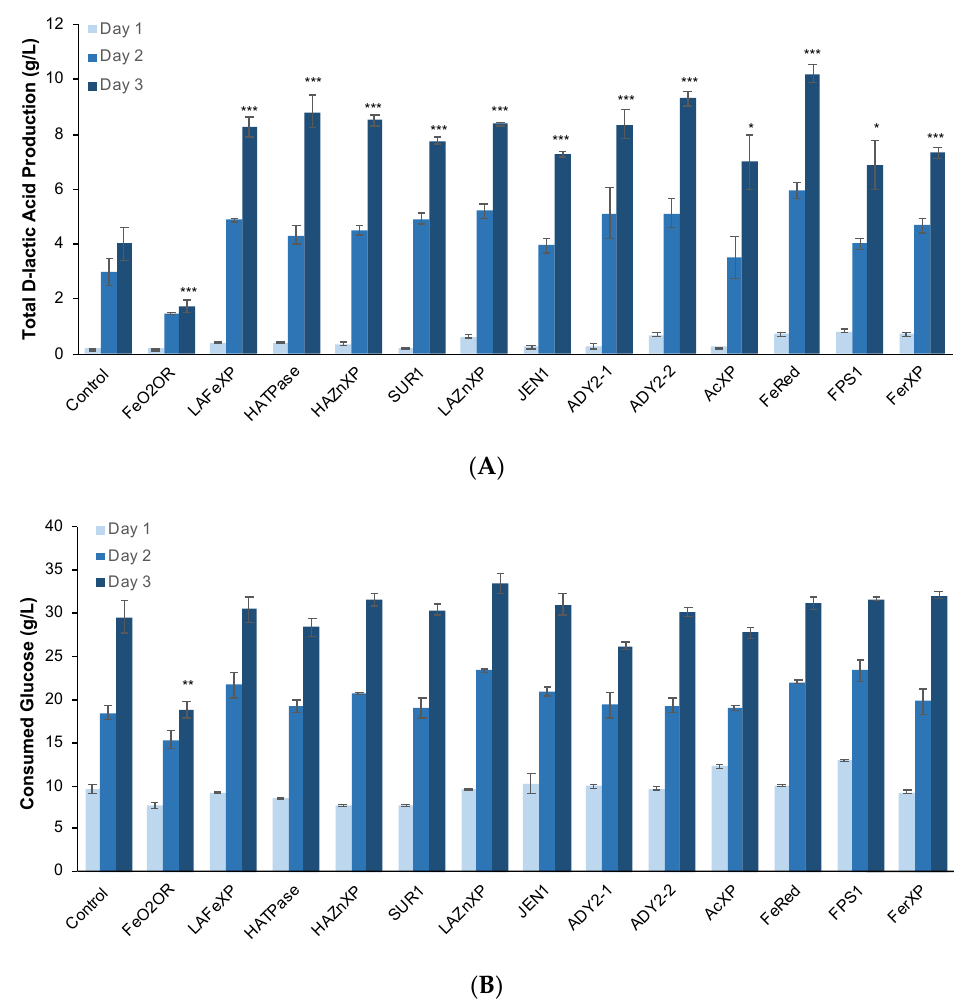
Figure 7. Overexpression of several DE genes improved the production of D -lactic acid. D -lactic acid production ( A ) and glucose consumption ( B ) of engineered P. pastoris strains overexpressing selected DE genes identified. Results are the mean of three biological replicates ( n = 3). Error bars represent the standard deviation. * p < 0.05, ** p < 0.01, *** p < 0.001, two-tail, unpaired, heteroscedastic Student’s t -test. Statistical signi fi cance is shown for Day 3 results relative to control.